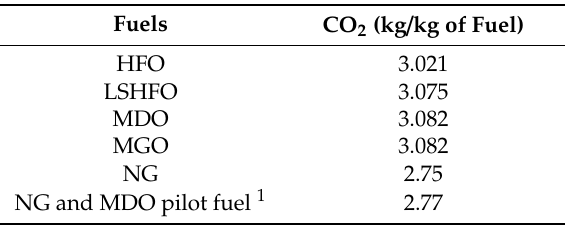
Table 8. CO 2 emission